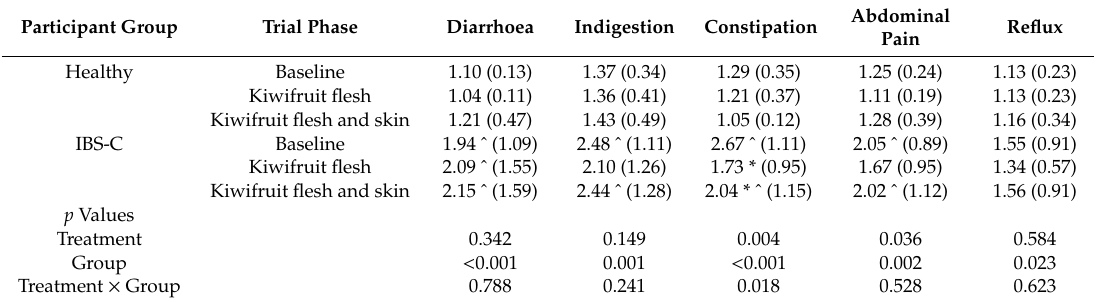
Table 5. Gastrointestinal symptom rating scale (GSRS) for the participants consuming Zespri ® SunGold kiwifruit ( Actinidia chinensis var. chinensis ‘Zesy002’) with and without skin 1 .